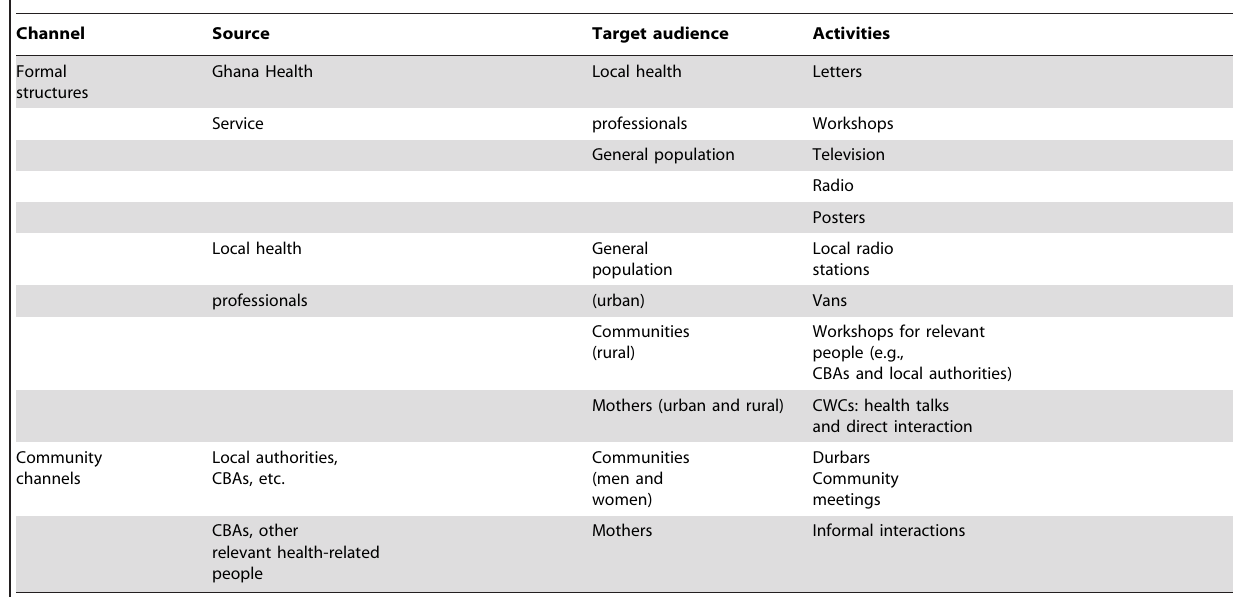
Table 5. Information channels and